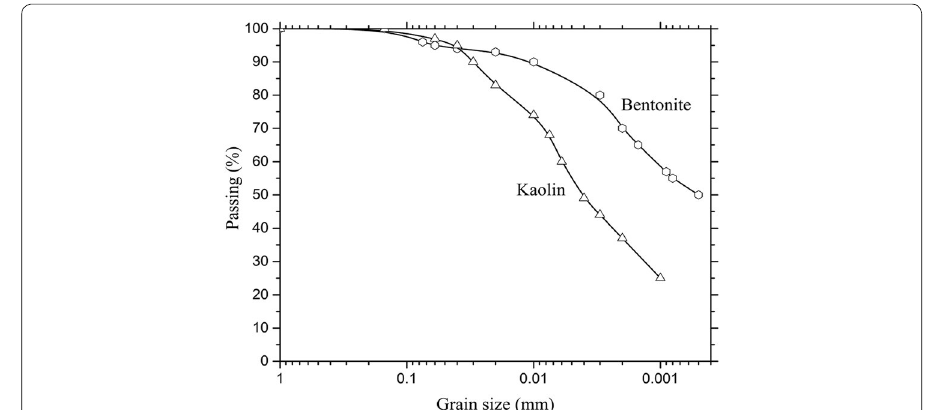
Fig. 1 Particle size distribution curves of the bentonite and kaolin used in this study